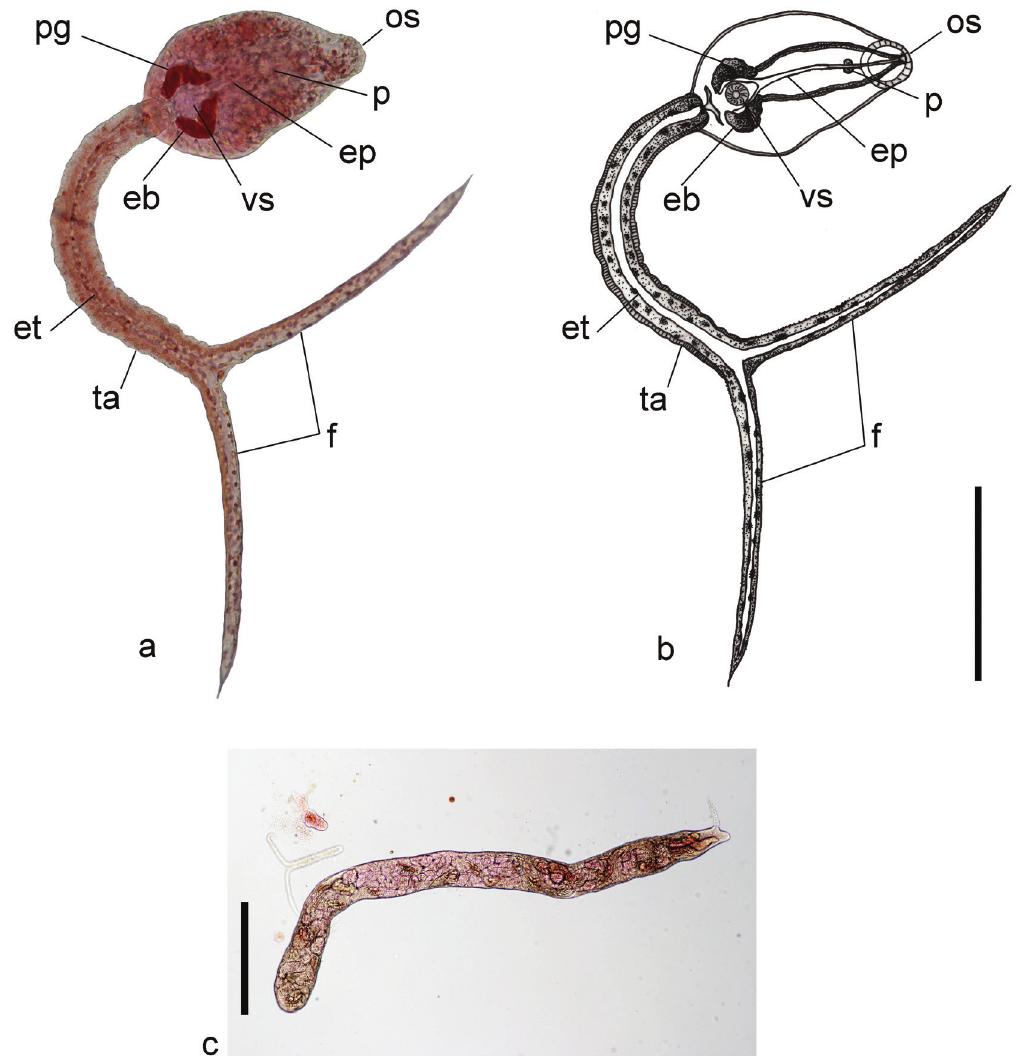
Figure 14. Alaria mustelae Bosma, 1931. a . specimen stained with 0.5% neutral red. b . drawing of cercaria. c . redia stained with 0.5% neutral red. Abbreviations – eb: excretory bladder; ep: esophagus; et: excretory tubule; f: furca; os: oral sucker; p: pharynx; pg: penetration gland; ta: tail; vs: ventral sucker. Scale bars: 50